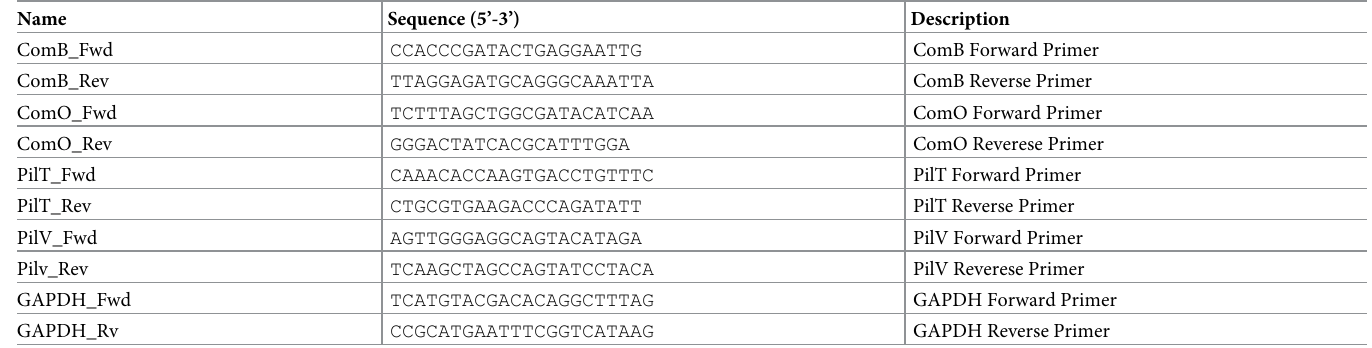
Table 1. Primer sequences for qRT-PCR.